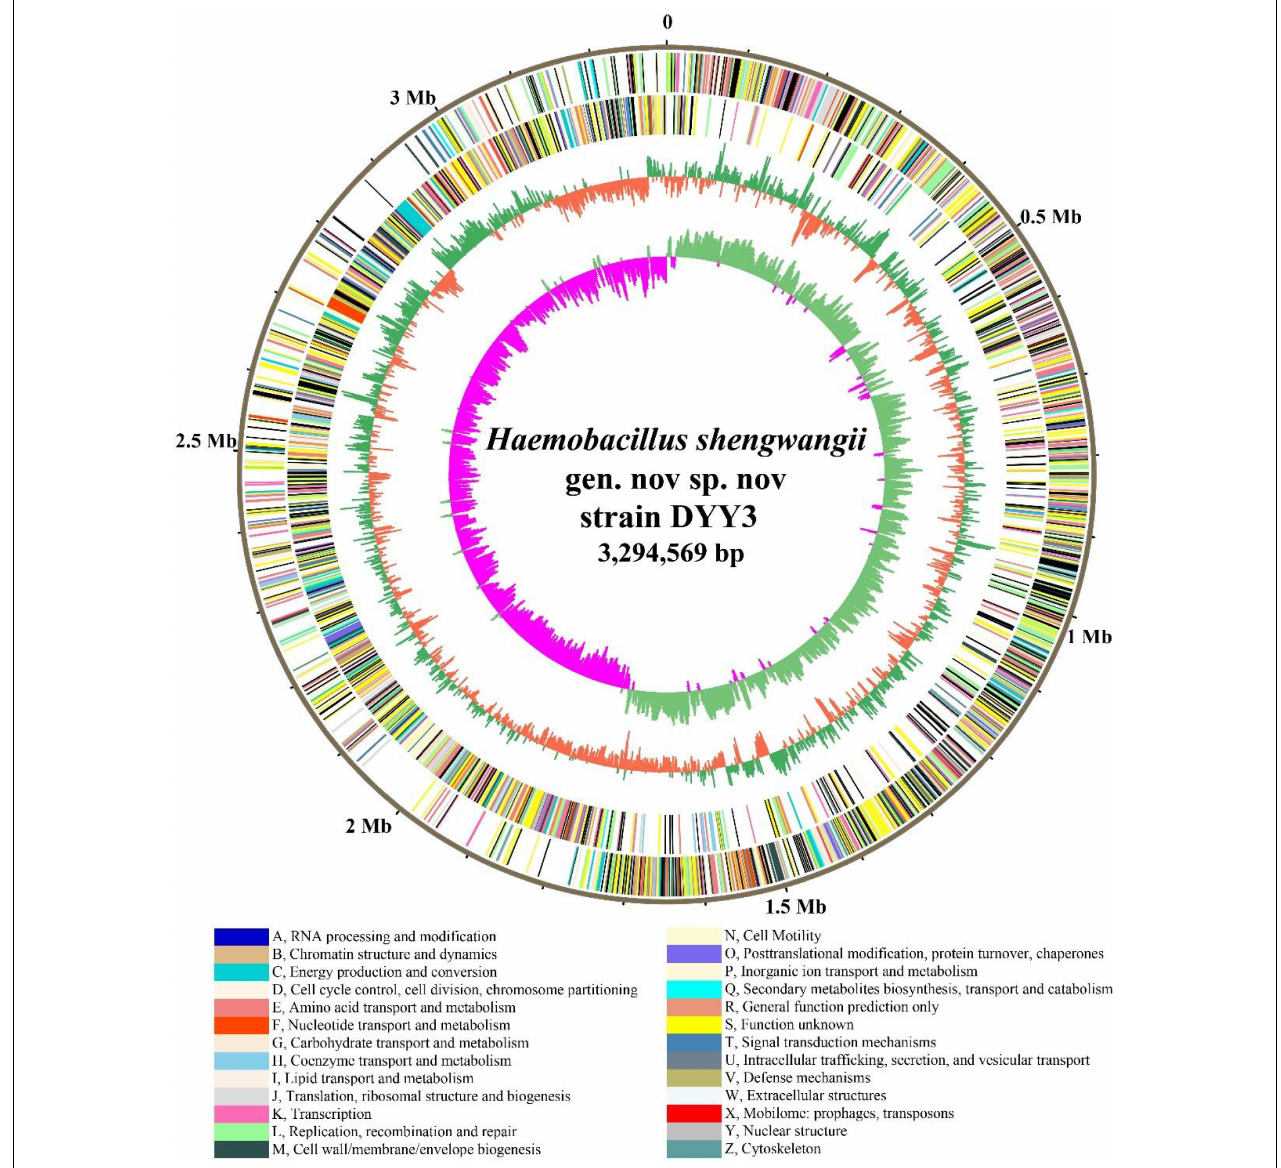
FIGURE 3 | Genome atlas of strain DYY3. The outer black circle shows the genome coordinates, and the next two circles represent forward and reverse strand CDSs with colors representing the functional classification of COG. The last two circles are GC content and GC skew using a 5-kb window overlapping at 1,000 bp. The COG functional classifications and colors are shown at the bottom of the figure. The green and orange colors of the fourth circle mean the GC content is higher and lower than the average GC content of the genome, respectively. The inner circle’s purple and light blue colors show the GC-skew values lower and higher than 0,